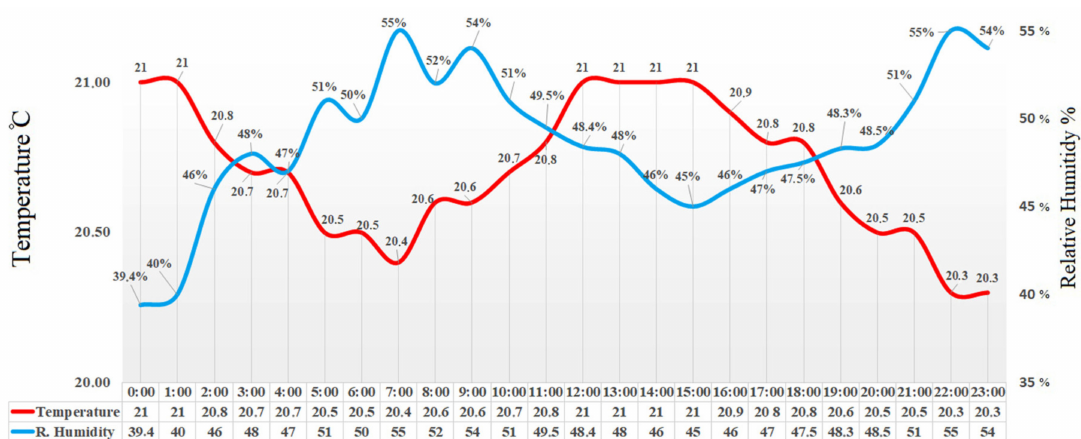
Figure 6. Internal